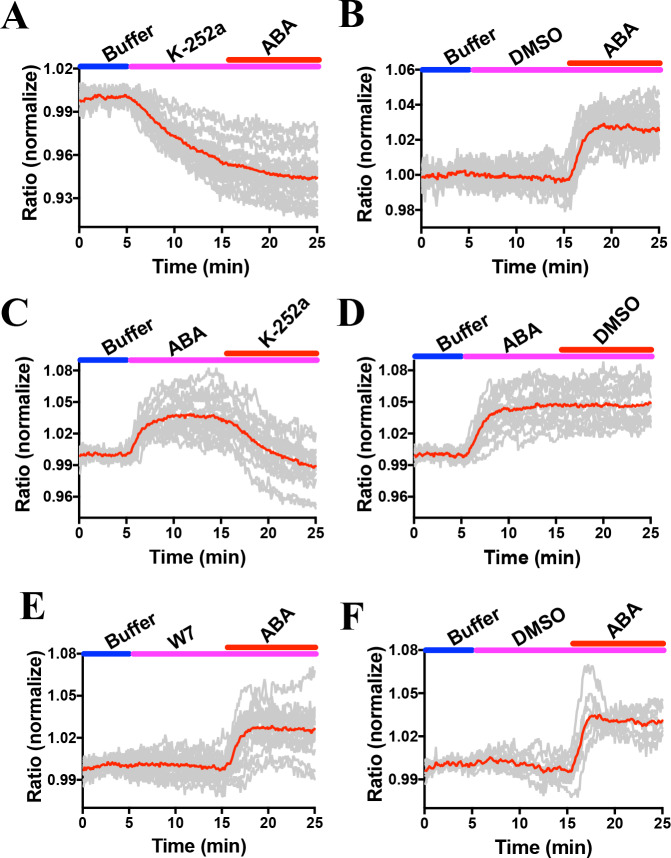
Combined and averages of single stomate imaging data from experimental sets including experiments in Figure 6.Red lines show the average ratio changes of all stomata traces. Grey lines denote each single stomate ratio change. For visualization of individual stomate time courses see colored traces in Figure 6. Additional data from independent experimental data sets are included in several panels of Figure 4—figure supplement 2, Figure 6—figure supplement 2, Figure 7—figure supplement 1 and Figure 8—figure supplement 1 as indicated by the total number of stomata analyzed in Supplementary Figure legends. (A) n = 22 stomata, including the data shown in Figure 6A. (B) n = 19 stomata, including the data shown in Figure 6B. (C) n = 17 stomata, including the data shown in Figure 6C. (D) n = 15 stomata, including the data shown in Figure 6D. (E) n = 19 stomata, including the data shown in Figure 6E. (F) n = 9 stomata, including the data shown in Figure 6F.Figure 6—figure supplement 2—source data 1.SNACS FRET ratio values from each stomate in Figure 6—figure supplement 2.